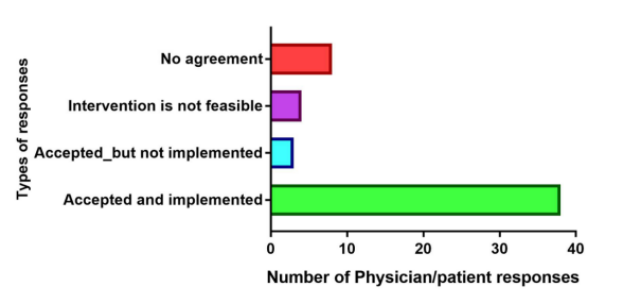
Figure 2: Clinical pharmacist’s interventions acceptance Table 4: Patient Factors associated with the acceptance/ implementation of pharmacist recommendations